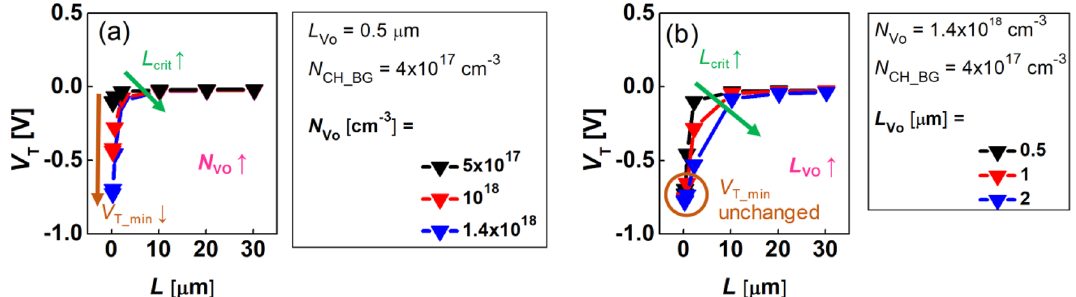
Figure 5. The TCAD simulation results for the L -dependent V T in BG FETs with the variations of ( a ) N Vo and ( b ) L Vo .